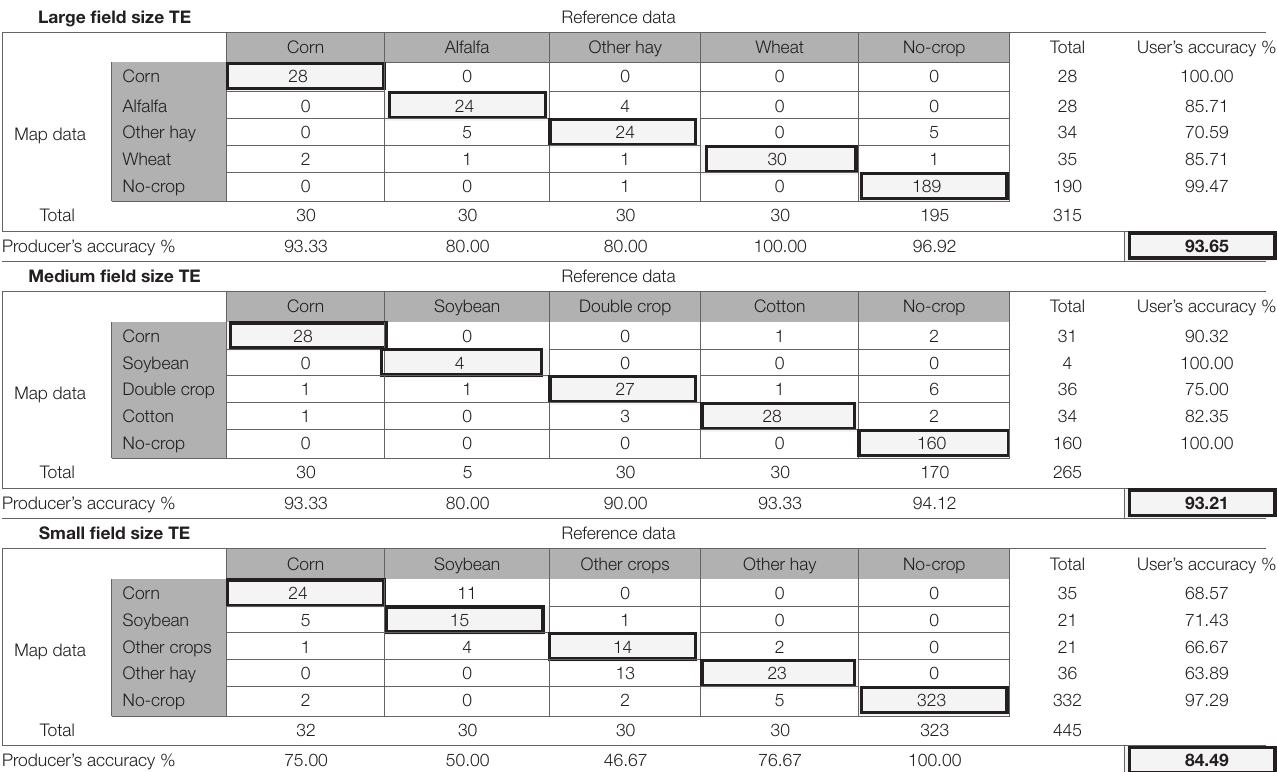
TABLE 5 | The error matrices of crop type maps generated from multi-dates of World View-2 imagery for the large, medium, and small agriculture field sizes TE